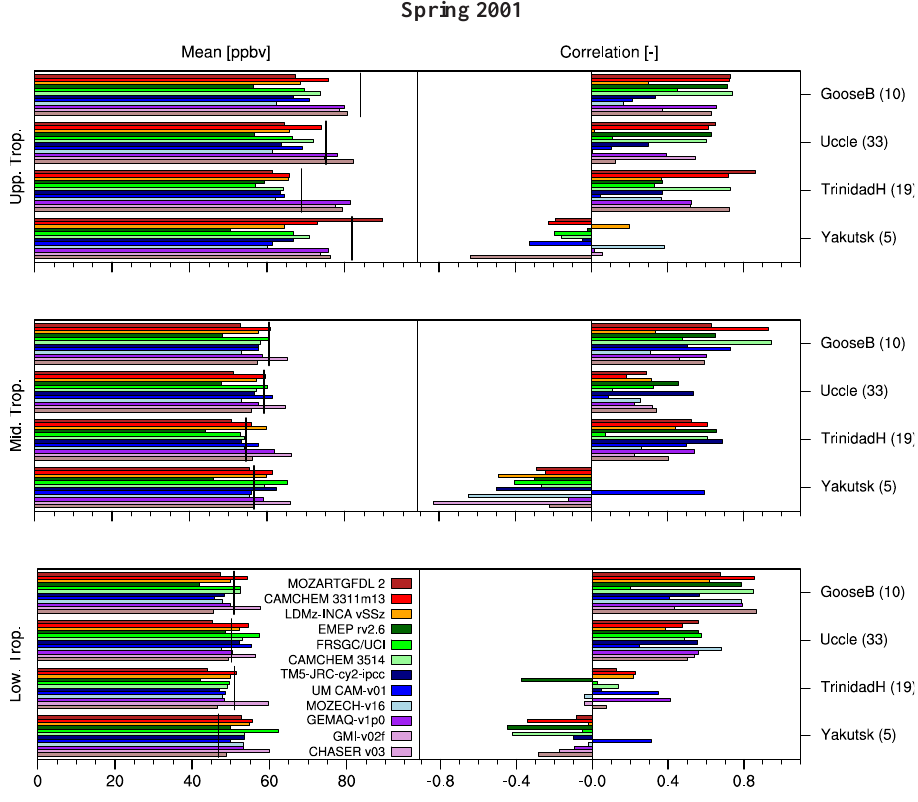
Fig. 4: Measured and model-calculated ozone (ppb) in spring (March, April, May) for the lower troposphere (900 - 700hPa), middle troposphere (700 - 500hPa) and upper troposphere (500 - 300hPa) for the selected ozonesonde sites. Concentrations to the left (solid lines crossing the model calculations are measurements), correlations to the right. The numbers behind the site name refer to the number of soundings available for comparison in Spring. GooseB. is short for Goose Bay, TrinidadH is short for Trinidad Head.